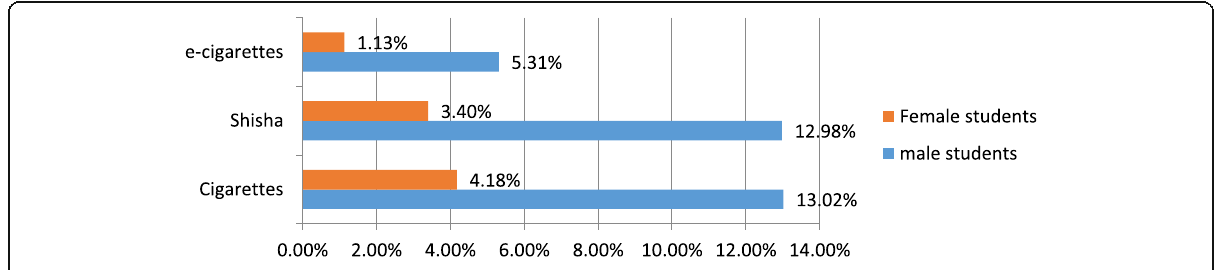
Fig. 1 Frequency of tobacco use according to